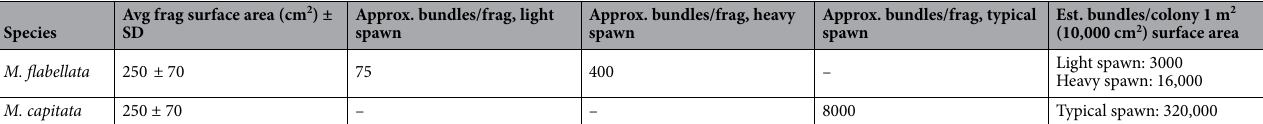
Table 2. Estimated reproductive output (egg-sperm bundles). A comparison of the number of egg-sperm bundles spawned on a given night was estimated for a 1 m 2 colony of M . flabellata and M. capitata . The mean number of bundles spawned per small colony fragment per night for both years was grouped into light and heavy spawning for M . flabellata and estimated for a typical M. capitata spawn. Given the sporadic spawning behavior of M . flabellata , similarly sized M. capitata colonies typically produce egg-sperm bundles an order of magnitude greater, or more, than M . flabellata on a given night of